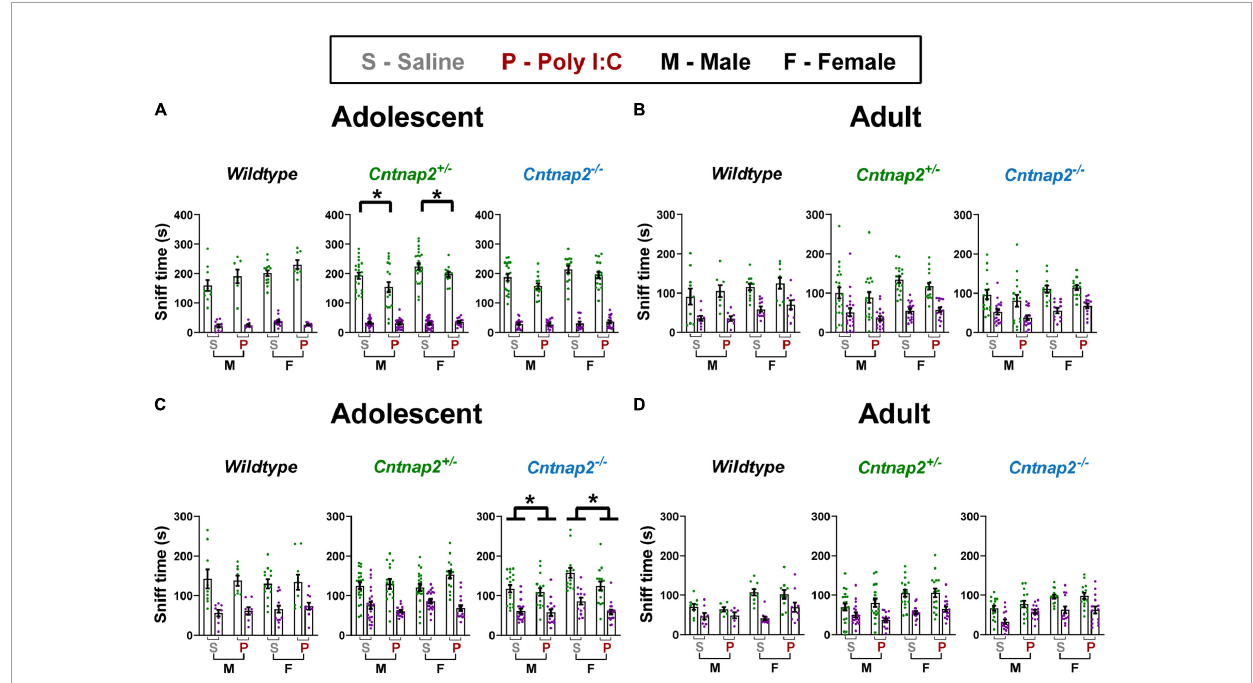
FIGURE7 Poly I:C reduces social exploration but not social preference in adolescent Cntnap2 + / − and Cntnap2 − / − offspring. In all groups at both ages, time spent in the social chamber/exploring the social animal holder was significantly more than the time spent in the non-social chamber/exploring the non-social animal holder, indicating that all groups showed strong preference for the social side/stimulus. (A) Poly I:C MIA reduced time spent sniffing the social stimulus in adolescent Cntnap2 + / − but not WT or Cntnap2 − / − offspring ( p = 0.013; indicated by the ∗ symbol). (B) There were no significant effects associated with Poly I:C MIA or Cntnap2 genotype in adult sociability exploration. (C) Cntnap2 − / − Poly I:C offspring spent significantly less time sniffing animal holders on both the social and non-social sides compared to their Cntnap2 − / − saline offspring. (D) There were no significant effects associated with Poly I:C MIA or Cntnap2 genotype in adult social novelty exploration. Data are shown as mean ± standard error. For information on sample sizes for each group, please see Table 1